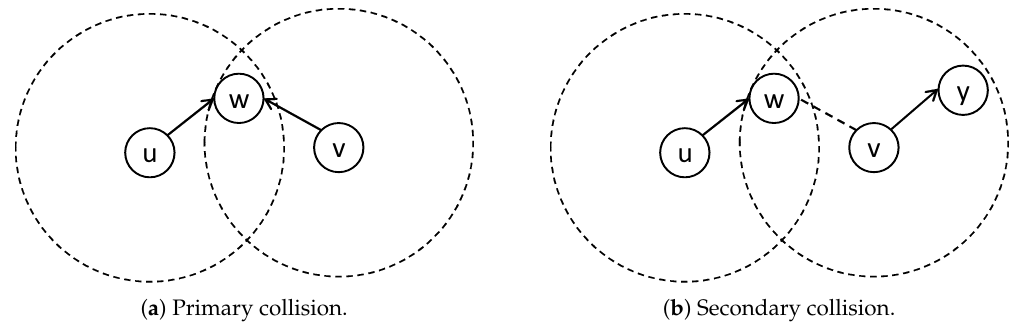
Figure 1. ( a ) Primary and ( b ) Secondary collisions. In both cases, node w cannot receive data if nodes u and v transmit at the same